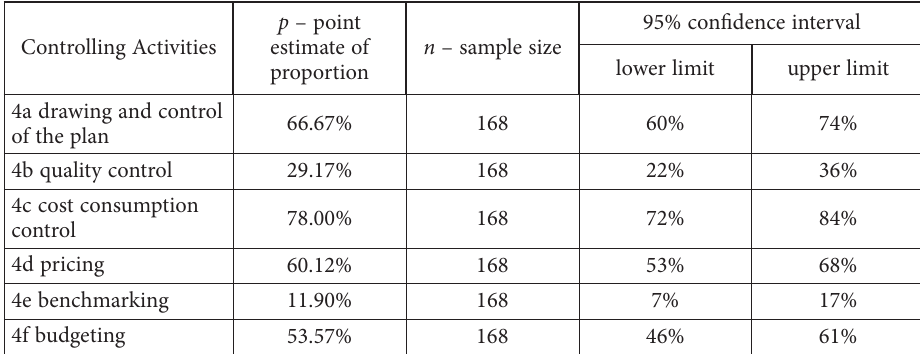
Table 4. Interval estimates of proportions enterprises using controlling activities